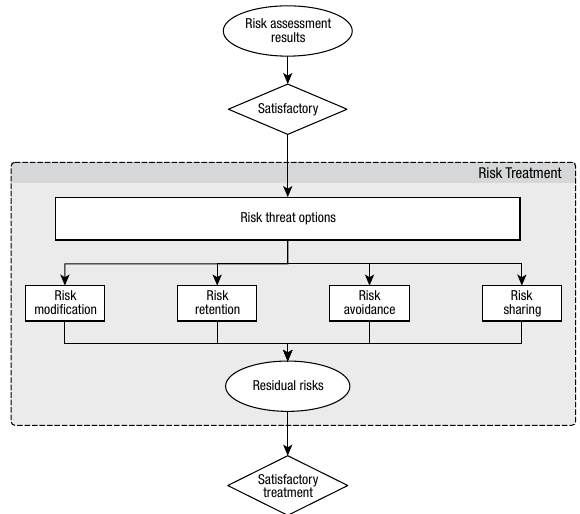
Fig. 3. Steps of risk assessment (Vandenbrink